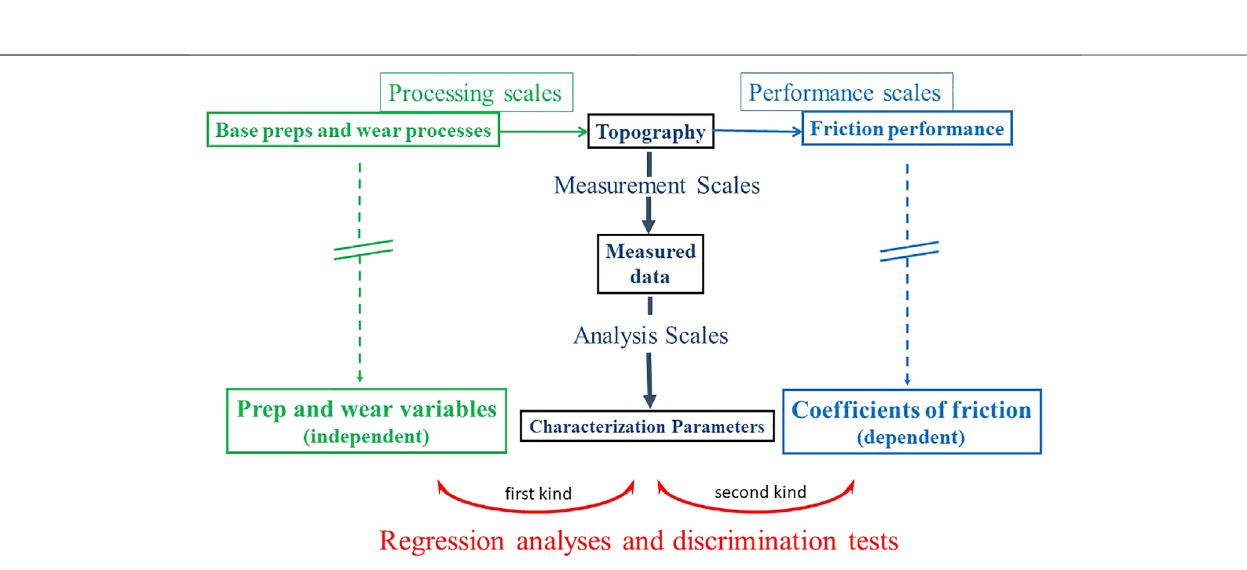
FIGURE5| Scales and relationsinsurface metrology. Processing in fl uencing topographies,arethe fi rstkind,on theleft. Topographiesin fl uencing performanceare the second kind, on the right.